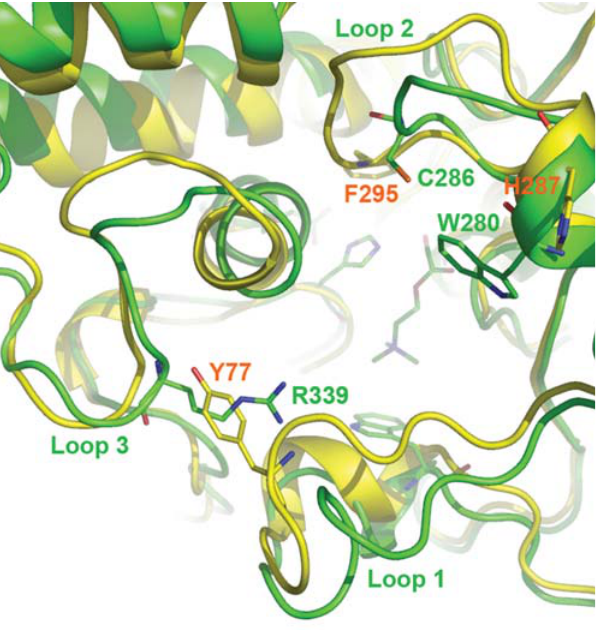
Figure 2. Overlay of Anophelesgambiaeand human acetylcholines- terases A. gambiae : green; human: yellow; perspective: looking down onto substrate acetylcholine at the catalytic site.